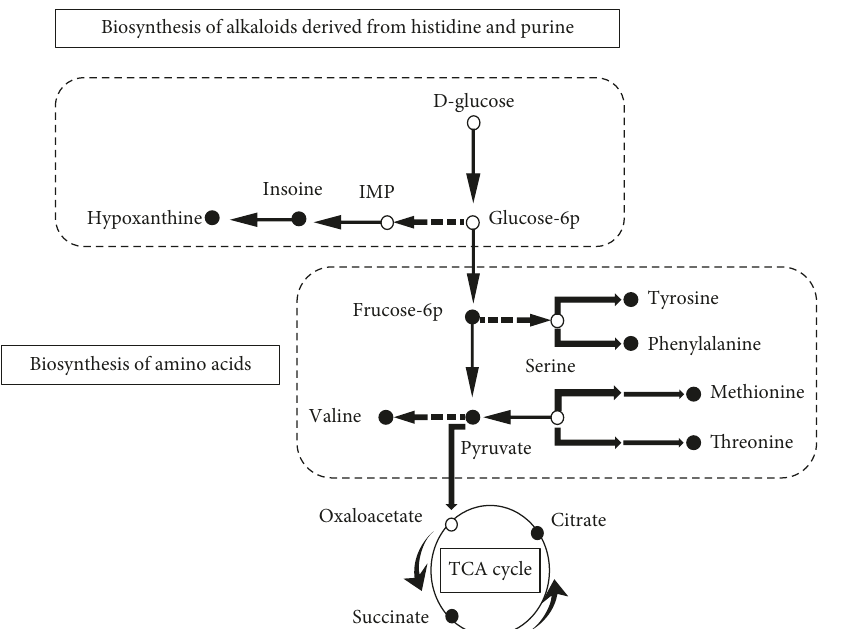
The values followed by different superscript letters were significantly different ( P < 0 . 05).